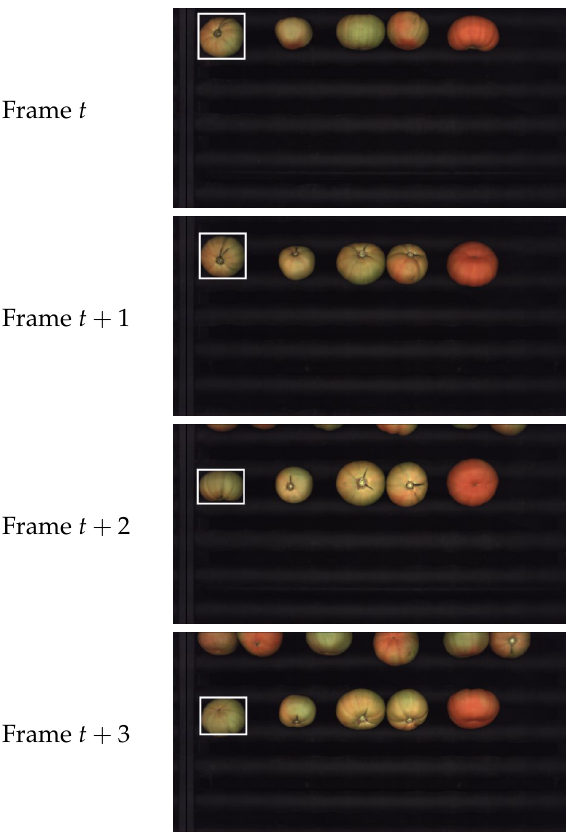
Figure 2. Four consecutive camera